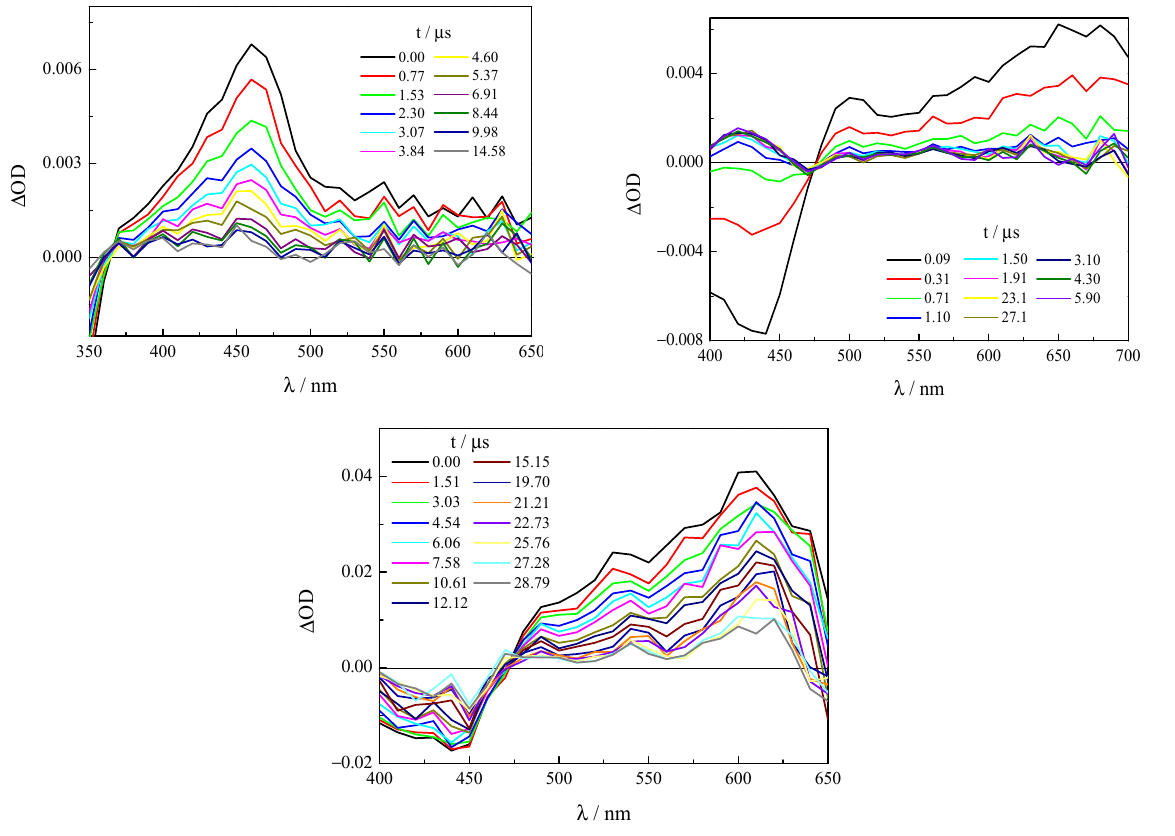
Figure 8. Nanosecond transient absorption spectra of DMA-QP ( top left ), DMA-QF ( top right ), and DMA-QT ( bottom ) in de-aerated Tol solutions obtained by laser flash photolysis ( λ exc = 355 nm).